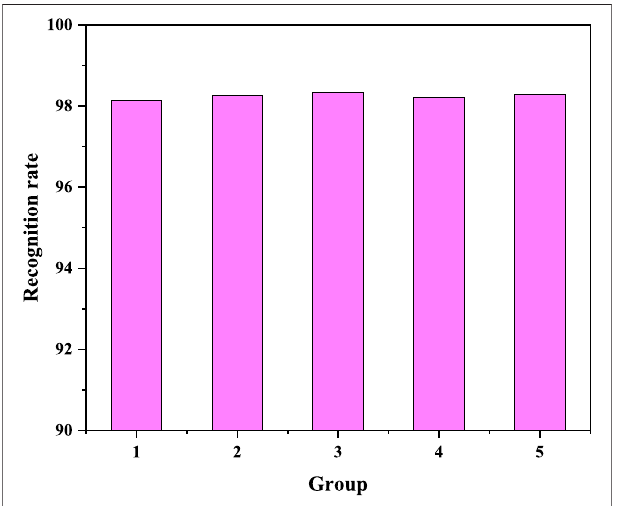
FIGURE 10 | Experimental results.